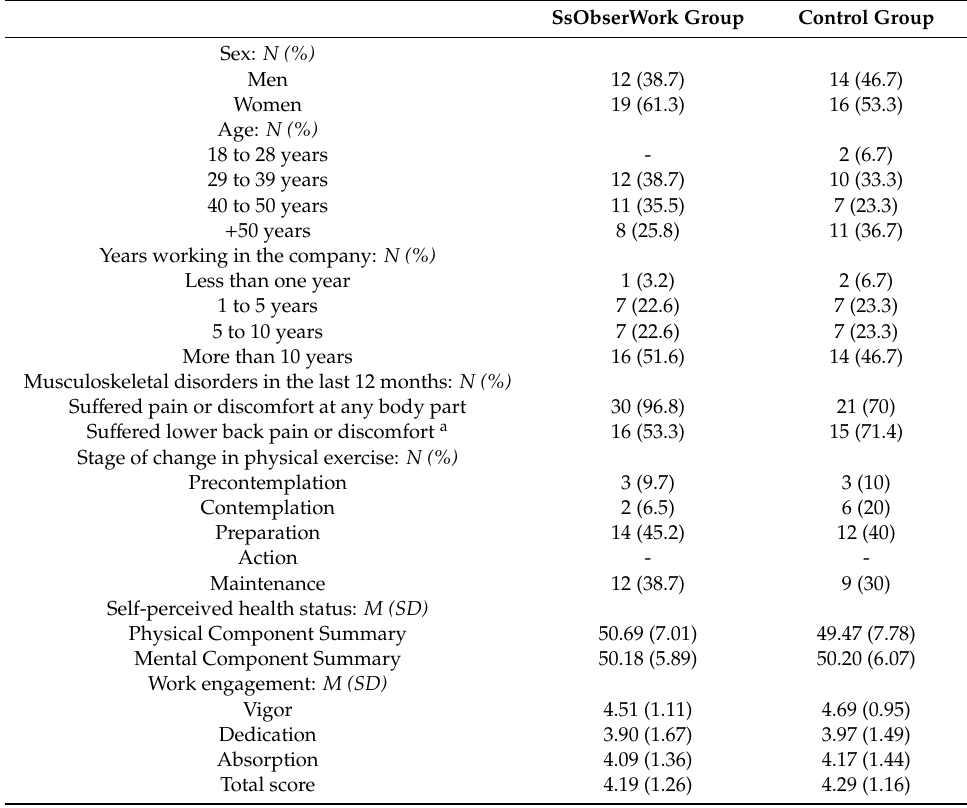
Table 1. Baseline characteristics of participants in both study